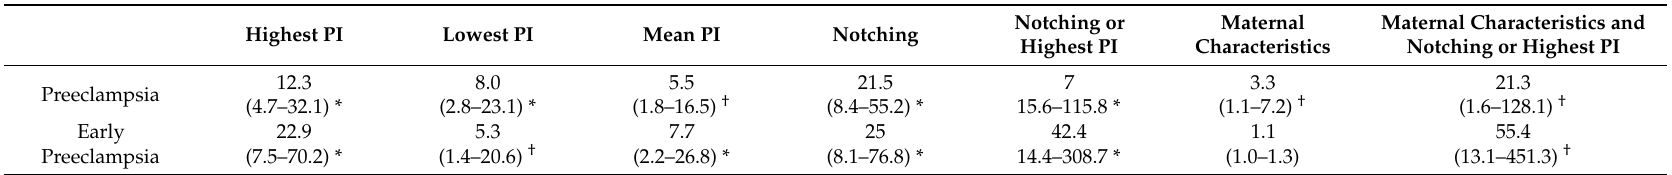
Notching or Maternal Maternal Characteristics and Highest PI Characteristics Notching or Highest PI